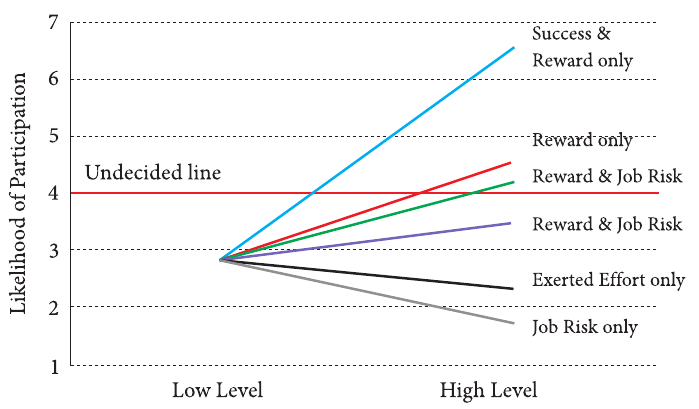
Fig. 3. Likelihood of CE participation based on level of